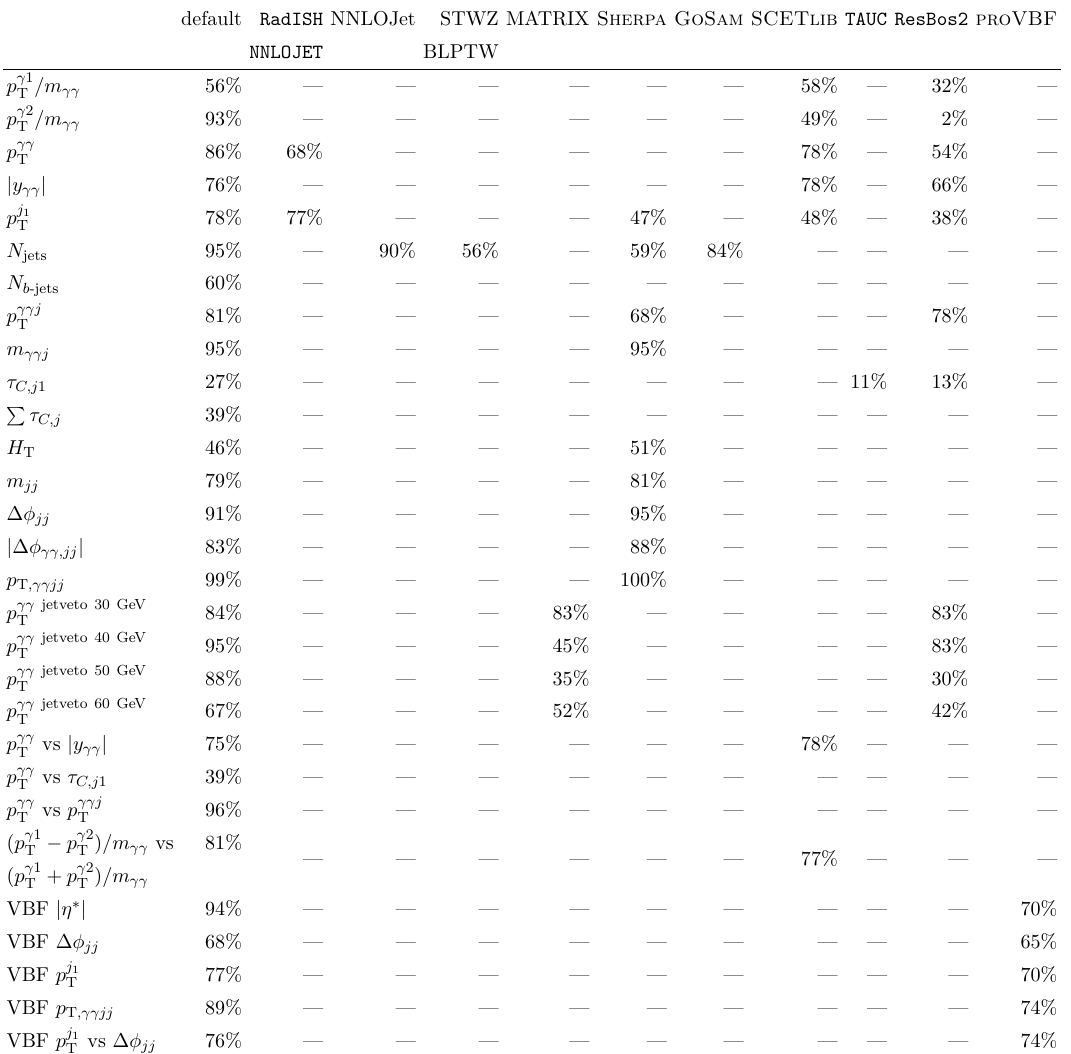
Table 5. The p -values obtained with a χ 2 compatibility test between the fitted cross-sections and the SM predictions for each differential distribution. The χ 2 is computed using the full set of uncertainties for the data, including their correlation, and for the SM predictions. The correlation of the SM predictions are neglected as most of the predictions are provided without this